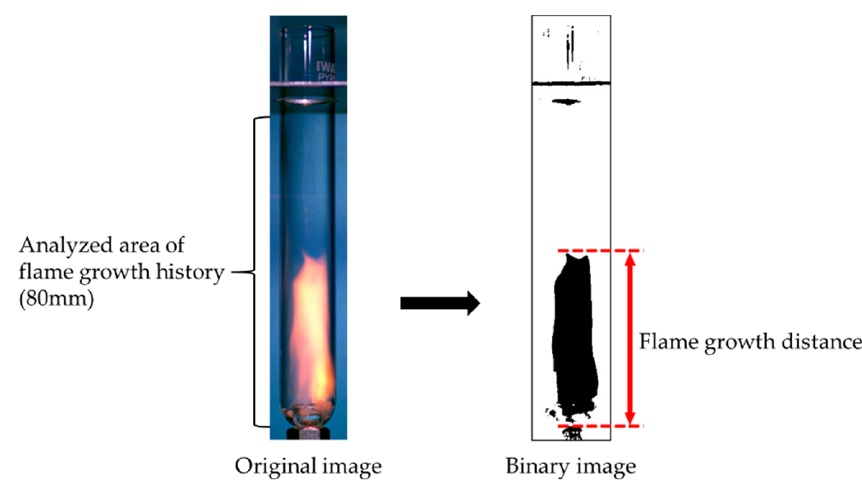
Figure 5. Explanation of image analysis for single ‐ drop test results.